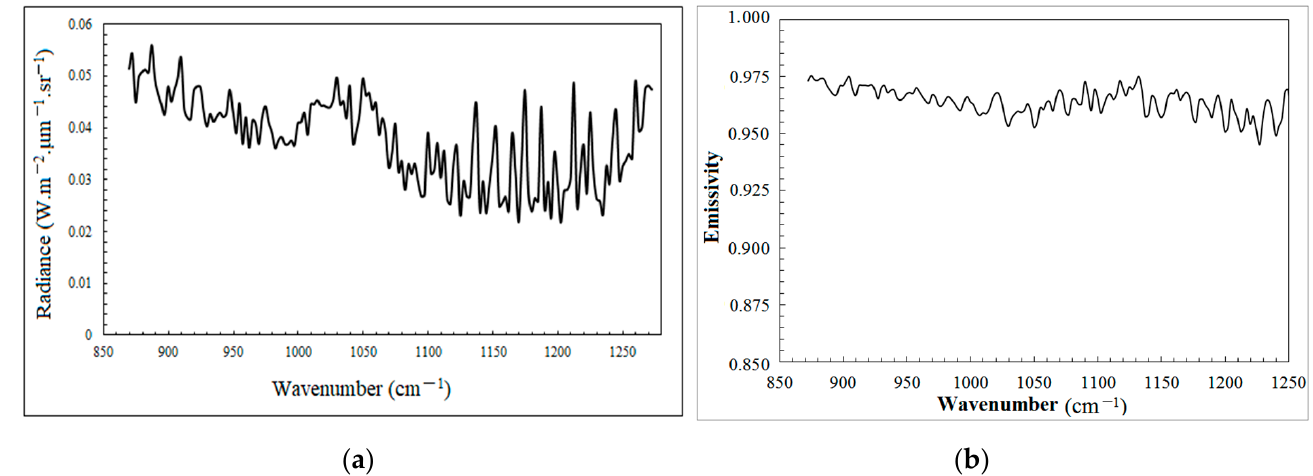
Figure 17. Temperature of Potentilla chinensis.